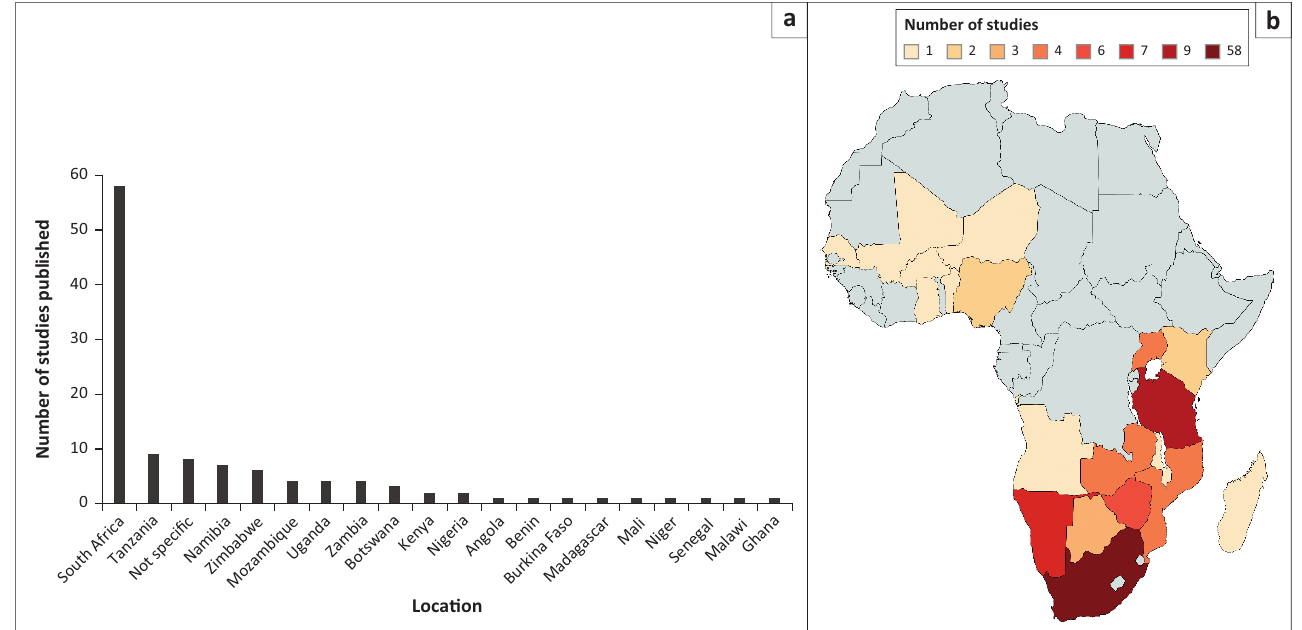
FIGURE 1: Origin of published sources on fire management in African savanna-protected areas.